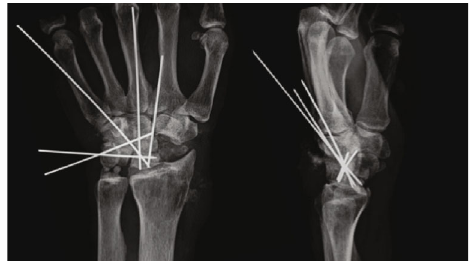
Figure 1: Plain X-ray fi ndings show sharpening of the styloid process, narrowing between the radial scaphoid bones, and growth of the dorsal ridge.